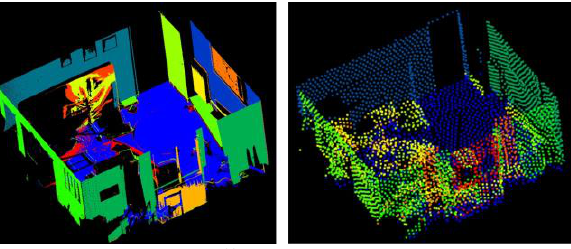
Figure 5. Room at two different resolutions, 2.5mm and 10cm.